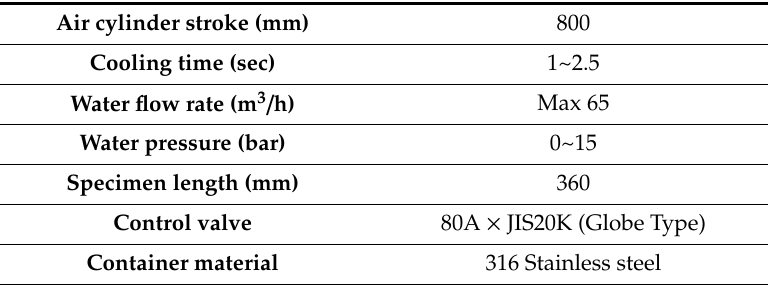
Figure 7. ( a ) Schematic of TPS system; ( b ) dual cylinder; ( c ) specimen transfer frame; ( d ) screw type Table 1. Main specifications of TPS. specimen clamping device. Table 1. Main specifications of TPS.